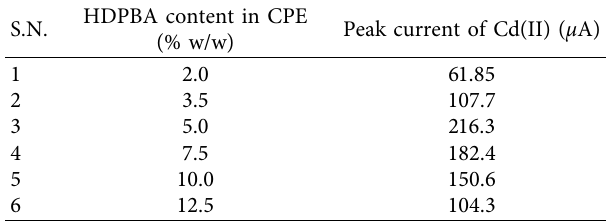
Figure 9: (a): SWASVs of 100nM Cd(II) in Britton Robinson (B-R) buffer (0.1M, pH 4) at (A) unmodified CPE and (B) HDPBA ‒ CPE. Accumulation time: 270s; potential − 1.0 V; amplitude:100mV; frequency: 80Hz; step potential: 6mV. (b): Square wave voltammograms of 100nM Cd(II) at HDPBA modified CPE in 0.1 M B-R solution (pH 4) (A) nondeaerated solution (0min), (B) deaerated solution for 5min, (C) dearated solution for 8min, and (D) dearated solution for 10min. Table 1: Influence of modifier (HDPBA) content in CPE on the current response of Cd(II).